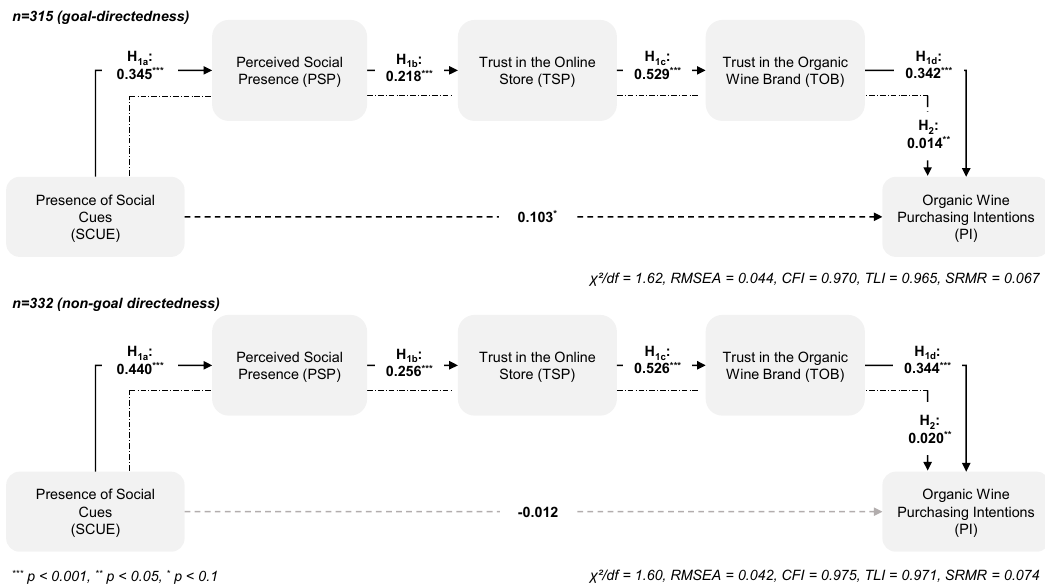
ff ects of the presence of social